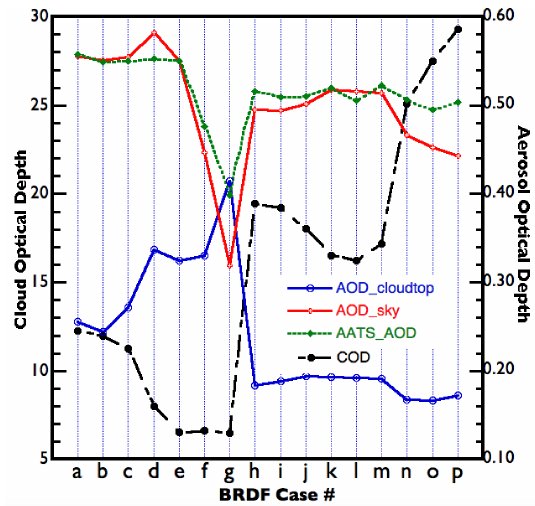
Figure 12. Comparison of the retrieved parameters averaged over all the viewing directions for each case